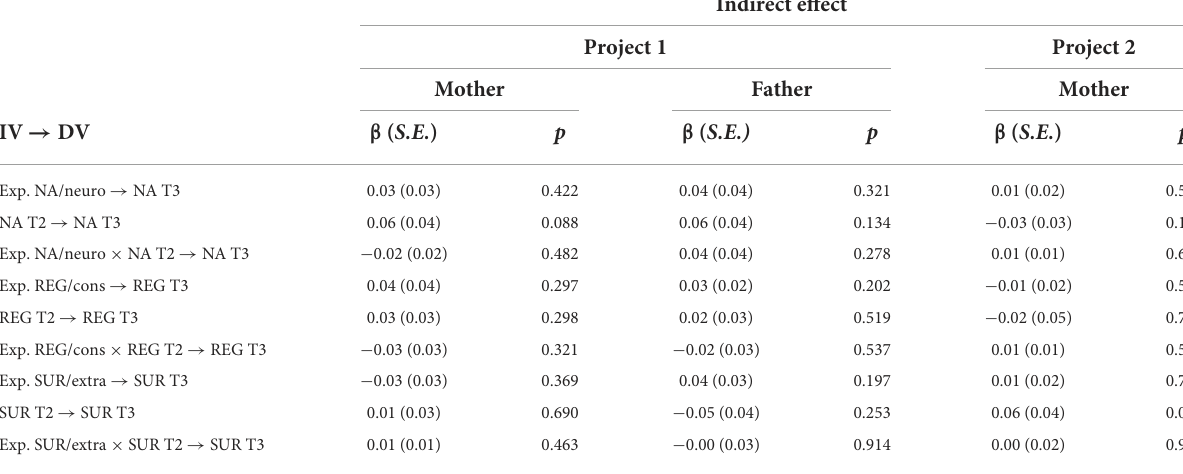
TABLE 7 Indirect effects of expected temperament, infant temperament T2, and their interaction, on temperament T3 via parenting